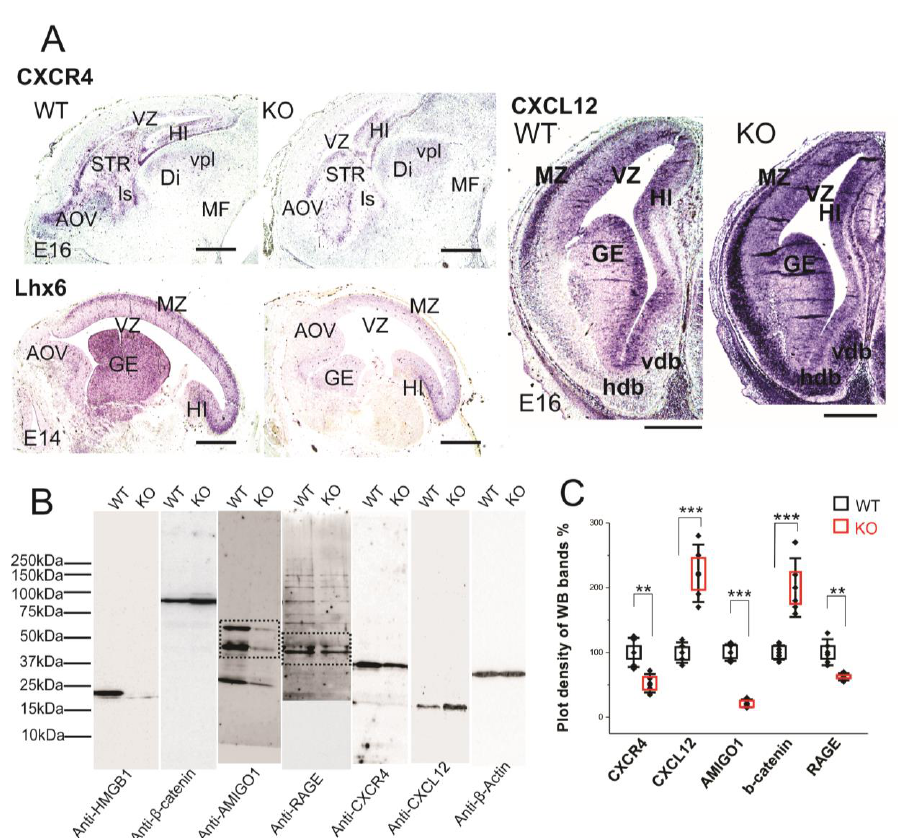
Figure 6. Expression of CXCR4 and CXCL12 in developing forebrain. ( A ) CXCR4 (E16 sagittal section), Lhx6 (E14 sagittal section) and CXCL12 (E16 coronal section) in situ hybridization. The HMGB1 KO mice showed decreased expression of CXCR4 and Lhx6, but increased CXCL12 in the developing cortex compared to the WT mice. Scale bars indicate 1mm. Abbreviations: AOV, ventral anterior olfactory area; Di, diencephalon; GE, ganglionic eminence; Hdb, horizontal nucleus of diagonal band of Broca; HI, hippocampus; ls, lateral septal nucleus; MF; mesencephalic flexure; MZ, Marginal zone; STR, striatum; Vdb, vertical nucleus of diagonal band of Broca; vpl, ventral posterior thalamic nucleus lateral; VZ, Ventricular zone. ( B ) Western blotting of E16 mouse brain samples. The same pair of the WT and KO samples has been used for the Western blotting for each antibody in one experiment. The experiment has been repeated with six pairs of the WT and KO E16 samples. On lanes with multiple bands the relevant areas have been encircled by rectangles. ( C ) Plot-density analysis of Western blotting bands of E16 brain samples. The HMGB1 KO mice showed significantly less expression of CXCR4, AMIGO1and RAGE than the WT mice. In contrast, the HMGB1 KO mice expressed much more CXCL12 and β -Catenin than the WT mice. Statistics of plot-density analyses has been obtained by six repeats. Mean values ± S.D. (error bars) and S.E.M (boxes) are indicated ( n = 6; *** p < 0.001; ** p < 0.01; unpaired t -test,